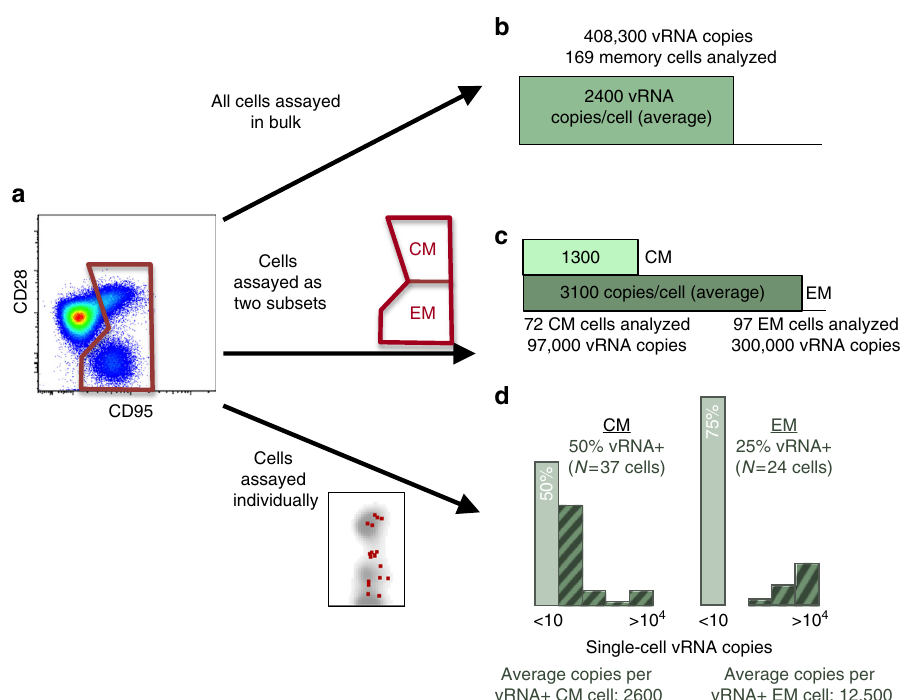
Fig. 1 Single cell approaches provide fi ner resolution and more accurate analysis of host – pathogen interactions than bulk analysis. a Populations of cells can be de fi ned by shared or distinct phenotypes (e.g., naive vs. memory (gated)). These populations of cells may differ in frequency of infection, and individual cells may differ in the number of pathogen transcripts expressed. These features of host – pathogen interactions can be ascertained with single-cell approaches. b Assay of all cells in bulk provides an inaccurate estimate of pathogen burden: there is no information about the frequency of infection and reports an average number of pathogen transcripts per cell (which does not re fl ect the actual number of transcripts in any of the cells assayed). c Sorting of cell populations (e.g., by fl uorescence-activated cell sorting) can better resolve relative differences in pathogen burden between cell phenotypes (e.g., central and effector memory, CM and EM, respectively), but remains misleading in terms of infection frequency and number of transcripts. d Single-cell analyses (e.g., cell sorting of one cell per sample well) reveals differential infection frequencies and pathogen burden per cell between CM and EM cell populations. In this example, infected cell frequency in CM exceeds that of EM (50% vs. 25%), but infected EM cells harbor a larger per cell viral